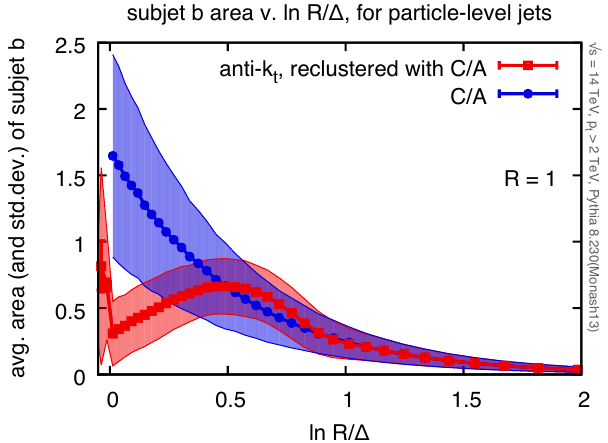
Figure 14. Average area (points), and standard deviation (band), of the softer subjet (subjet b ) in the Lund plane declusterings, shown as a function of (cid:1) for C/A jets (blue) and for C/A-reclustered anti- k t jets